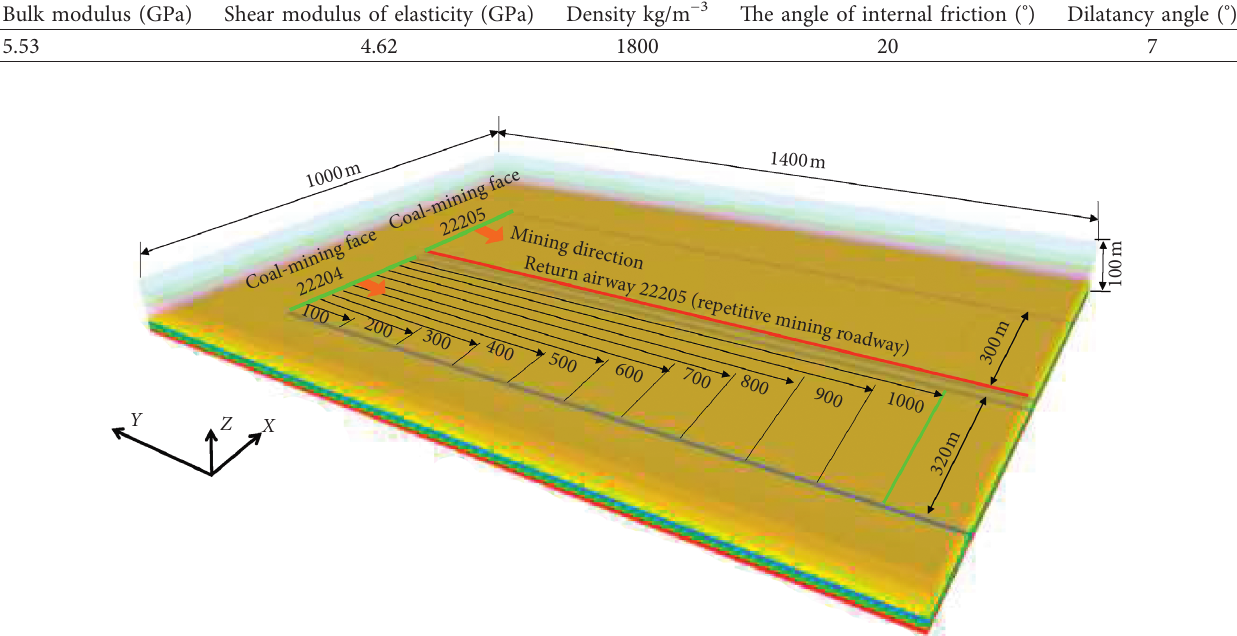
Table 3: Material mechanics parameters for caved rock.